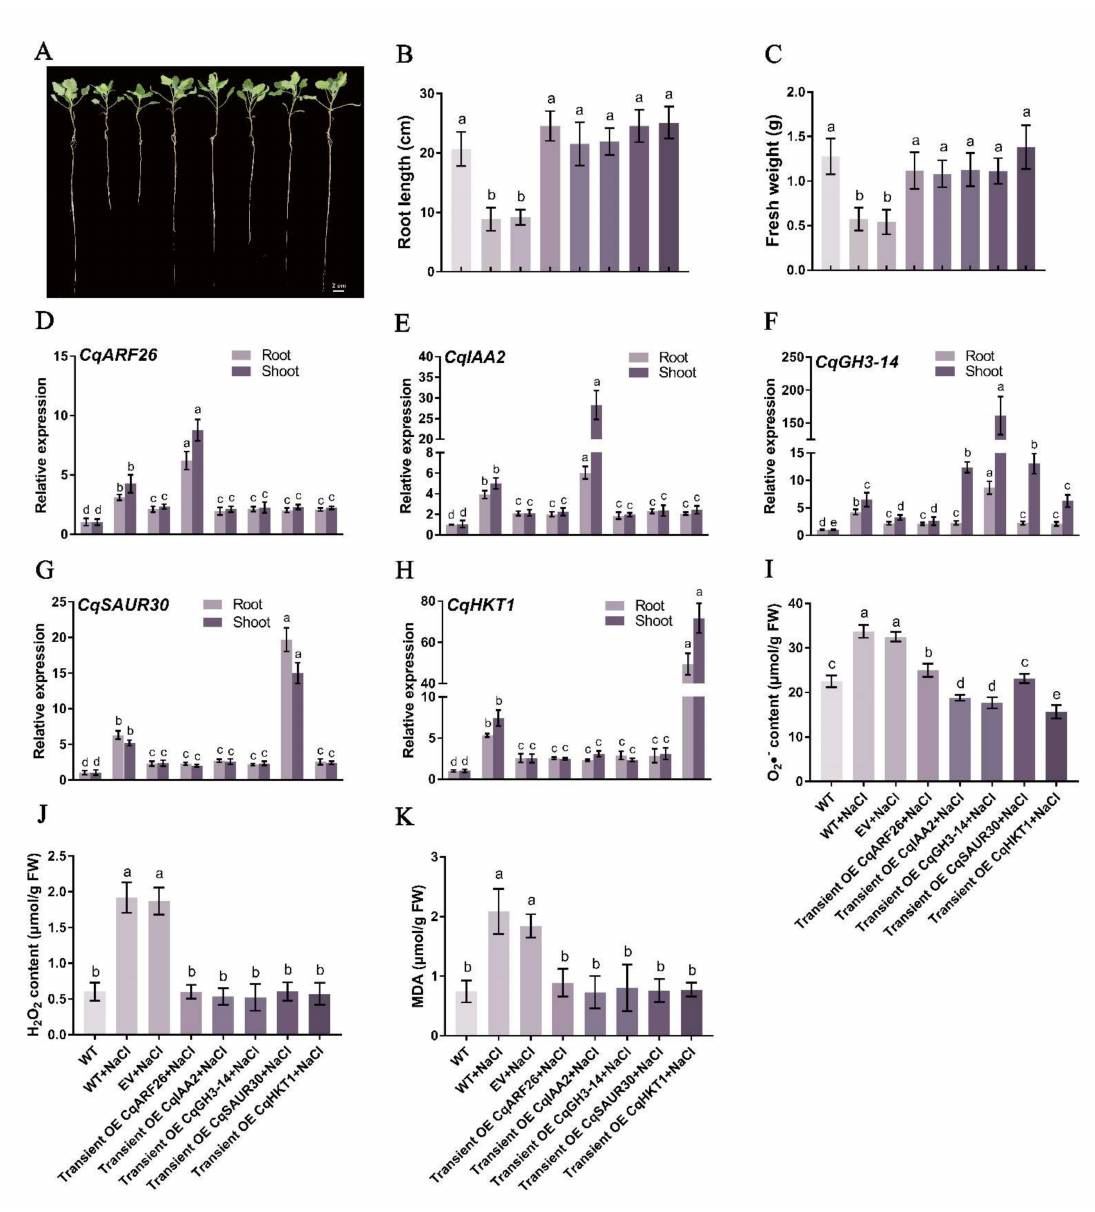
Figure 8. Effect of CqARF26 , CqIAA2 , CqGH3-14 , CqSAUR30 and CqHKT1 on salt tolerance in quinoa seedling roots. Relevant indicators of all these quinoa seedling roots in different treatments were determined. ( A ) The effects of CqARF26 , CqIAA2 , CqGH3-14 , CqSAUR30 and CqHKT1 on the phenotype of quinoa seedlings under salt stress. Bar = 2 cm. ( B ) The root length. ( C ) The fresh weight. ( D ) Expression analysis of CqARF26 in quinoa root and shoot under salt stress after transient overexpression of CqARF26 . ( E ) Expression analysis of CqIAA2 in quinoa root and shoot under salt stress after transient overexpression of CqIAA2 . ( F ) Expression analysis of CqGH3-14 in quinoa root and shoot under salt stress after transient overexpression of CqGH3-14 . ( G ) Expression analysis of CqSAUR30 in quinoa root and shoot under salt stress after transient overexpression of CqSAUR30 . ( H ) Expression analysis of CqHKT1 in quinoa root and shoot under salt stress after transient overexpression of CqHKT1 . ( I ) The O2 • − content changes in quinoa roots under different treatments. ( J ) The H 2 O 2 content changes in quinoa roots under different treatments. ( K ) The MDA content changes in quinoa roots under different treatments. Values are the mean ± SD ( n = 3). Different letters (a–e) in Figure 8B − K indicate significant differences at p < 0.05 according to one-way ANOVA (comparing the mean of each column with the mean of every other column) in GraphPad Prism